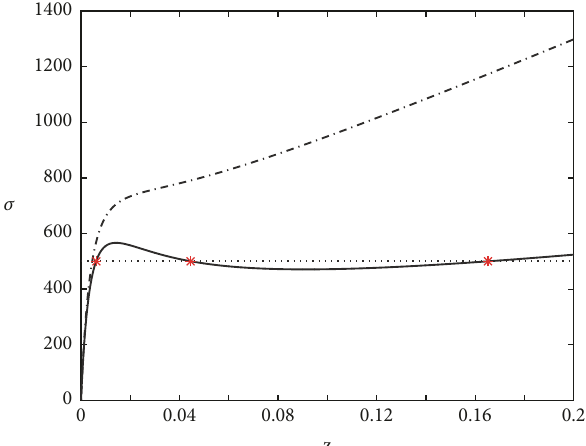
Figure 3: Mass conservation constant 𝜎 = 𝐵 𝑇 𝑐 versus 𝑧 for two sets of parameters (Example 1). The continuous line ( 𝛼 = 1 , 𝛽 = 100 , 𝛾 = 10 ) shows three equilibria (stars) for the compatibility class at 𝜎 = 500 (dotted line). The dashed line ( 𝛼 = 100 , 𝛽 = 100 , 𝛾 = 10 ) shows unique solutions in every compatibility class.